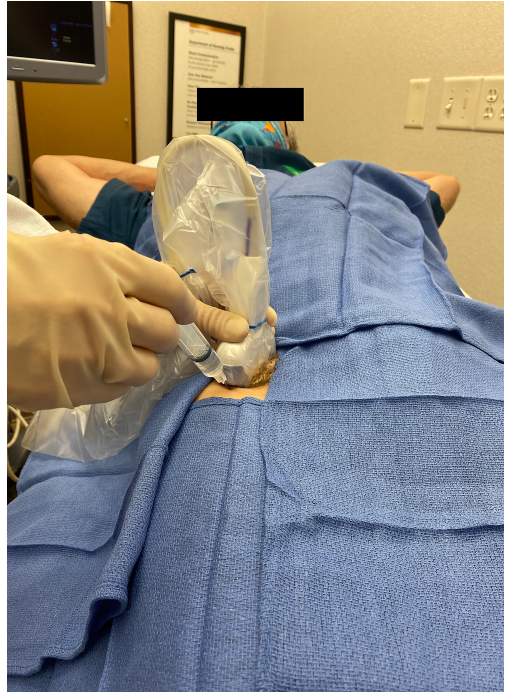
Figure 2. Transducer position.